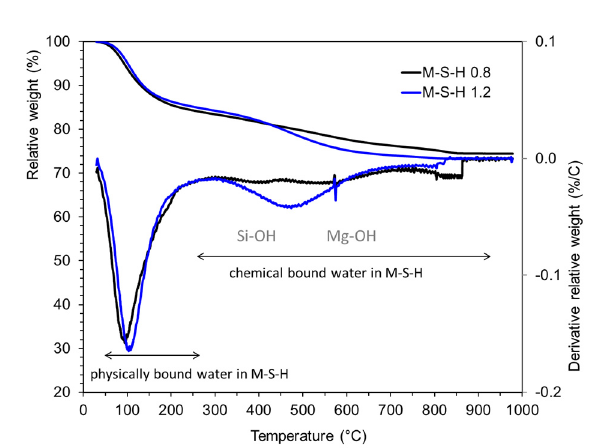
Figure 3. Thermogravimetric analysis on typical M ‐ S ‐ H (adapted from [41]). The large amount of water, particularly the poorly